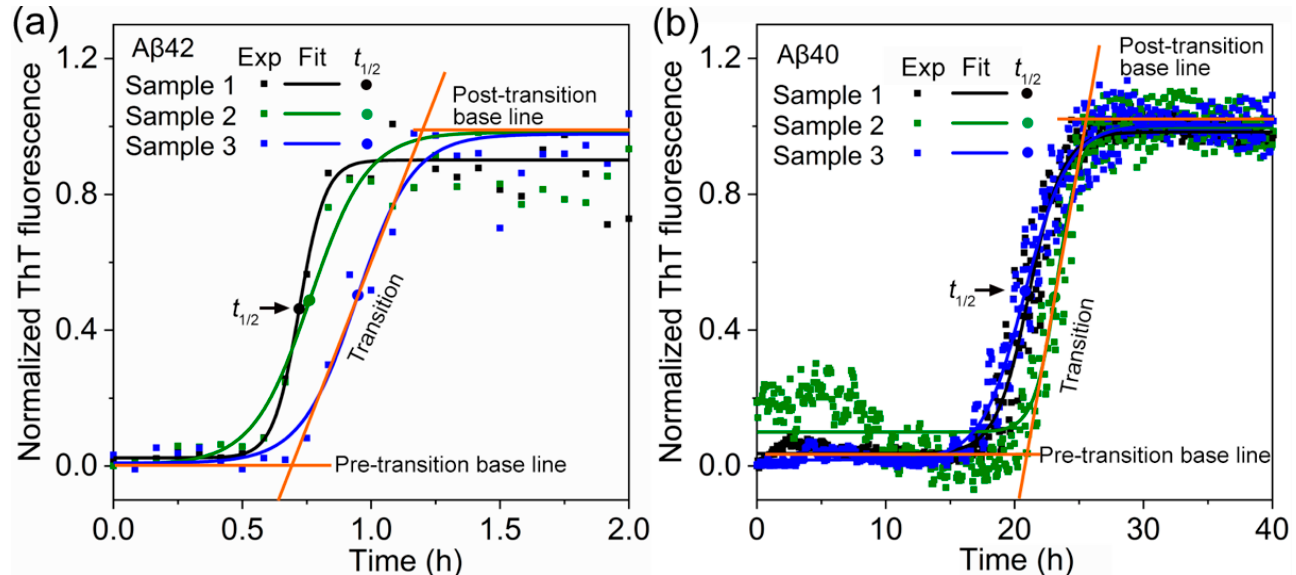
Figure 1. ThT-fluorescence spectrum as a function of incubation time for a solution containing (a) A β 42 or (b) A β 40, at a concentration of 10 µM for each solution.